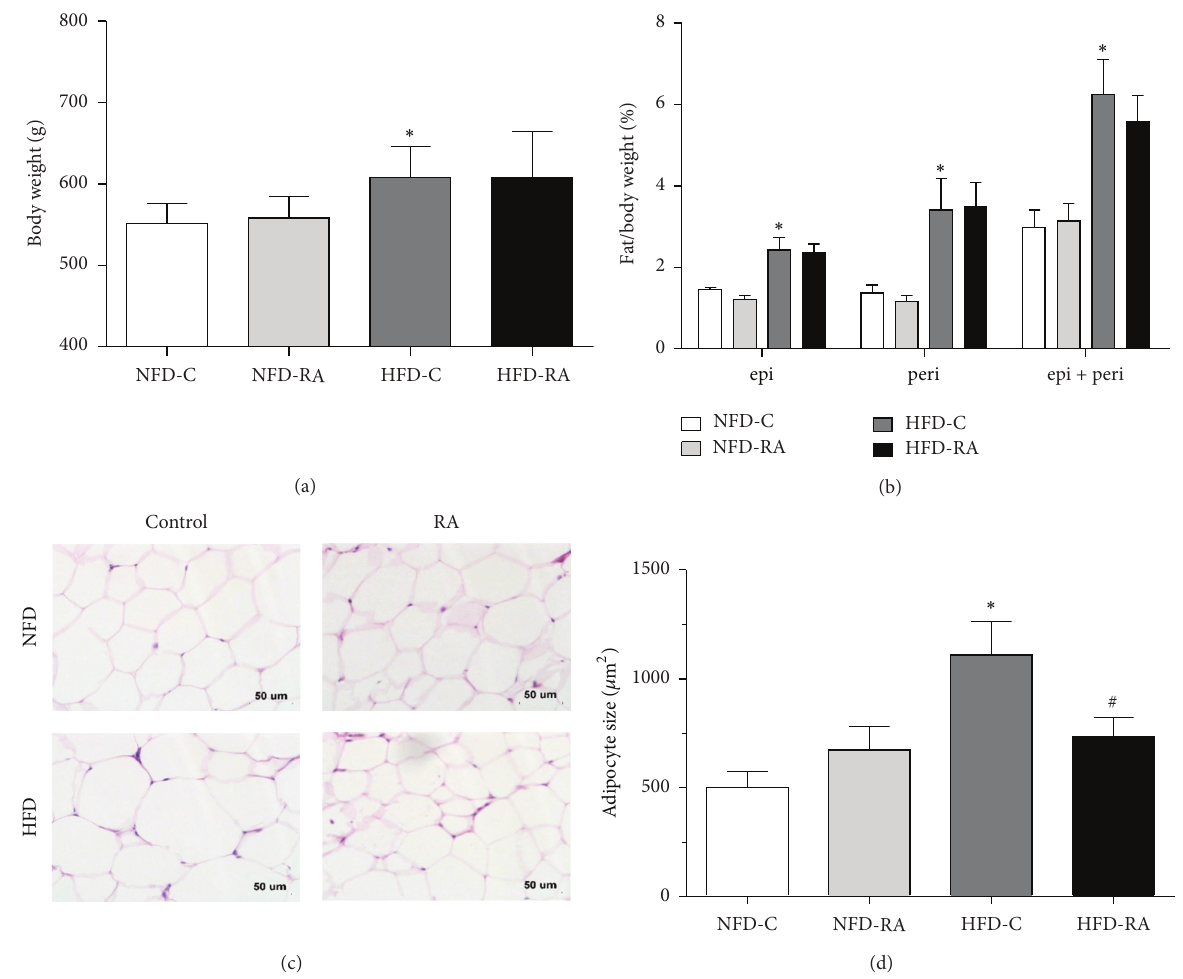
Figure 1: RA treatment has no effect on body weight and intra-abdominal white adipose tissue mass but decreases adipocyte size. (a) Body weights of rats fed standard chow without RA administration (NFD-C) and with RA administration (NFD-RA), high-fat diet without RA administration (HFD-C) and high-fat diet with RA administration (HFD-RA) (20 weeks, here and throughout, except as noted, 𝑛 = 5 – 8/group) (b) epididymal (epi), perirenal (peri), and epi + peri fat pad weights (normalized to body weights here) in rats in the NFD-C, NFD-RA, HFD-C, and HFD-RA groups (20 weeks, 𝑛 = 5 –8/group). (c) Histology of epididymal adipose tissue from rats in the NFD-C, NFD-RA, HFD-C, and HFD-RA groups. Scale bar: 50 𝜇 m. (d) Mean adipocyte size in rats in the NFD-C, NFD-RA, HFD-C, and HFD-RA groups ( 𝑛 = 5 /group). ∗ 𝑃 < 0.05 (HFD-C group versus NFD-C group) and # 𝑃 < 0.05 (HFD-RA group versus HFD-C